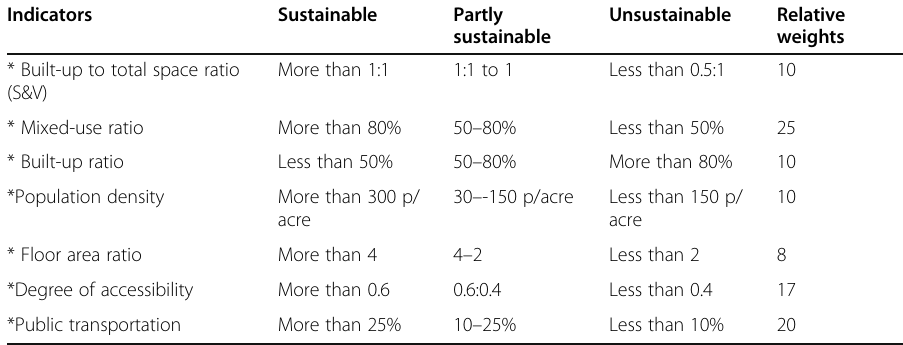
Table 4 Values assigned by experts for each economic sustainability indicator and relative weight